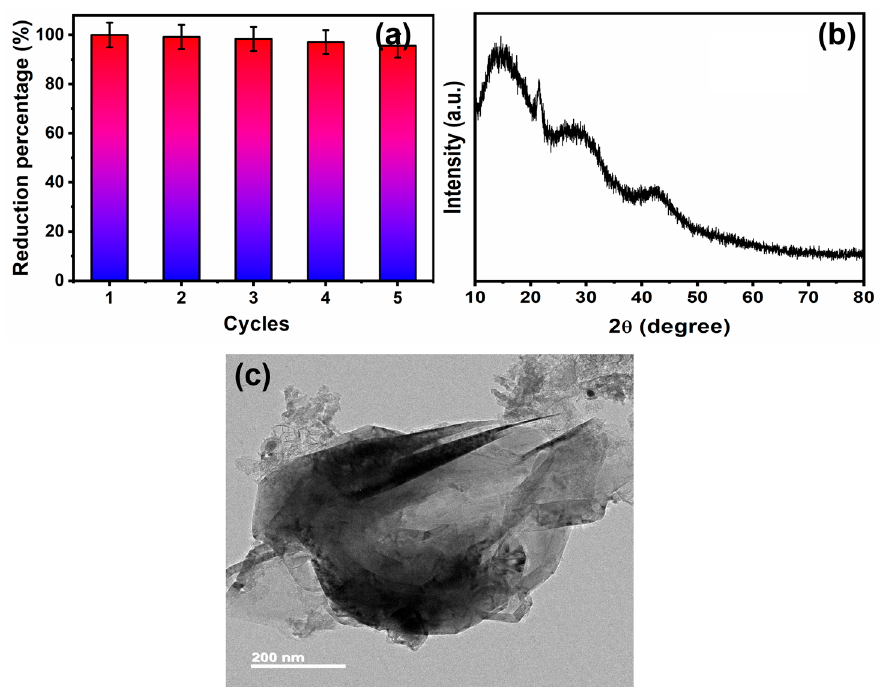
Figure 8. ( a ) Reusability test, ( b ) XRD pattern, and ( c ) FE-TEM image of NBP-PC-Zn after five cycles.